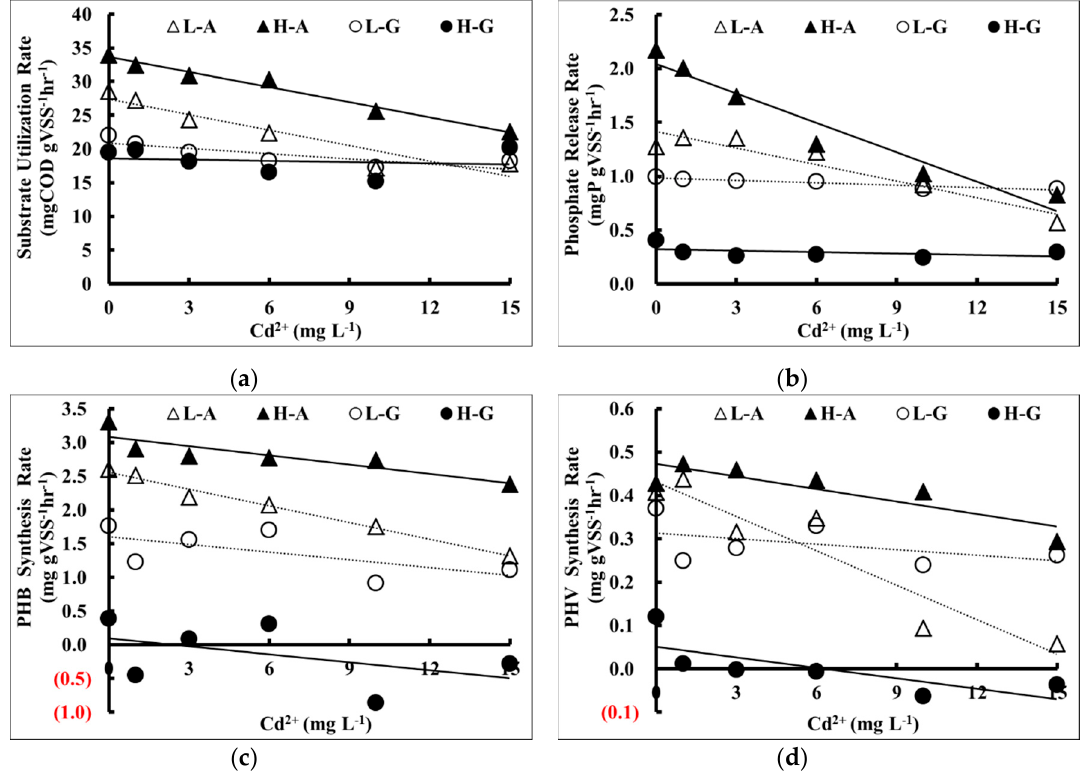
Figure 5. ( a ) Substrate utilization, ( b ) phosphate release, ( c ) PHB synthesis, and ( d ) PHV synthesis with shock loading of Cd 2+ under anaerobic conditions. (L-A: low concentration acetic acid, H-A: high concentration acetic acid, L-G: low concentration glucose, H-G: high concentration glucose ).